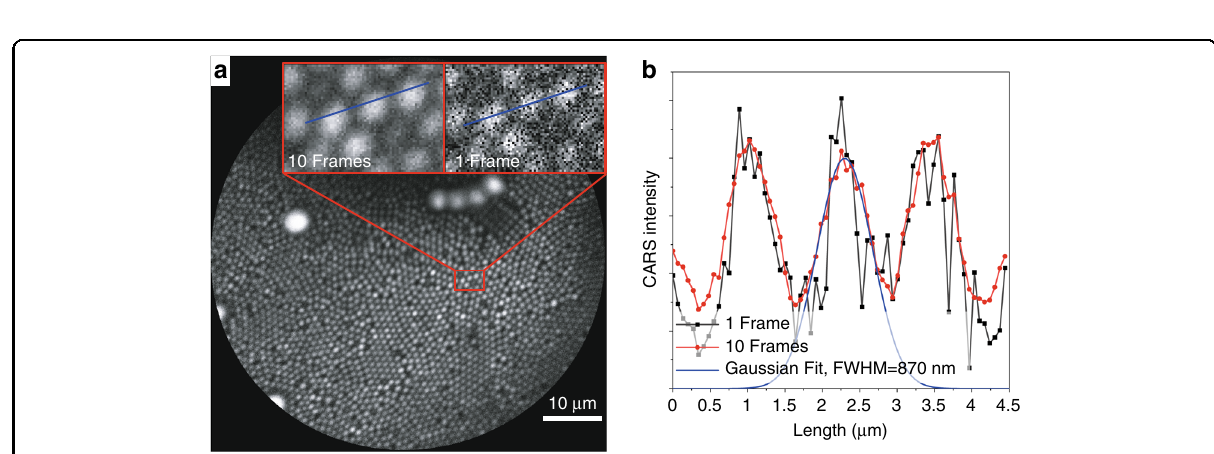
Fig. 4 Spatial resolution measurement of the endomicroscopic objective. Resolution test with a mixture of polystyrene beads with a diameter of 1, 3, and 6 µm at 70 µm FoV ( a ) CARS image (10 frames average) of polystyrene beads at 2850 cm − 1 . The close-up red rectangle presents 1 µm beads. The image quality of 1 frame is compared with the average of 10 frames. b Gaussian fi t on the intensity pro fi le along the blue line shown in ( a ). The FWHM of a single bead is 870 nm and the center-to-center distance is about 1.25 µm. The zero levels of the Gaussian fi t is adjusted to the noise level of the detection system. By averaging of 10 frames, the noise is signi fi cantly